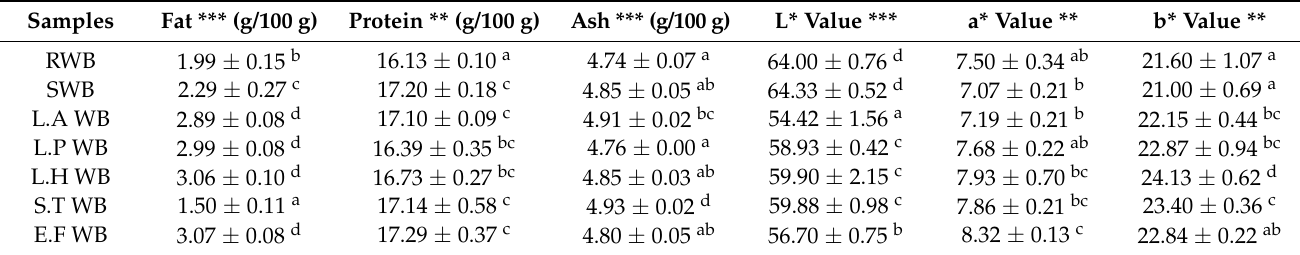
Table 1. Physicochemical characteristics of raw and fermented wheat bran.